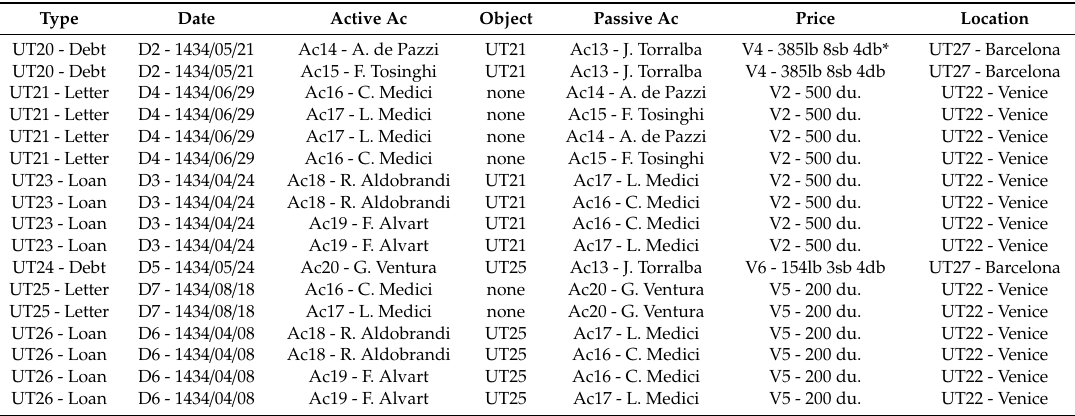
Table A3. Specific transaction dataset built upon the relationship between Actors, UT, Date, and Values obtained from Example